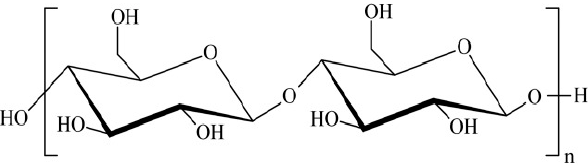
Figure 1. The structure of cellulose (Mariano et al. [32]).